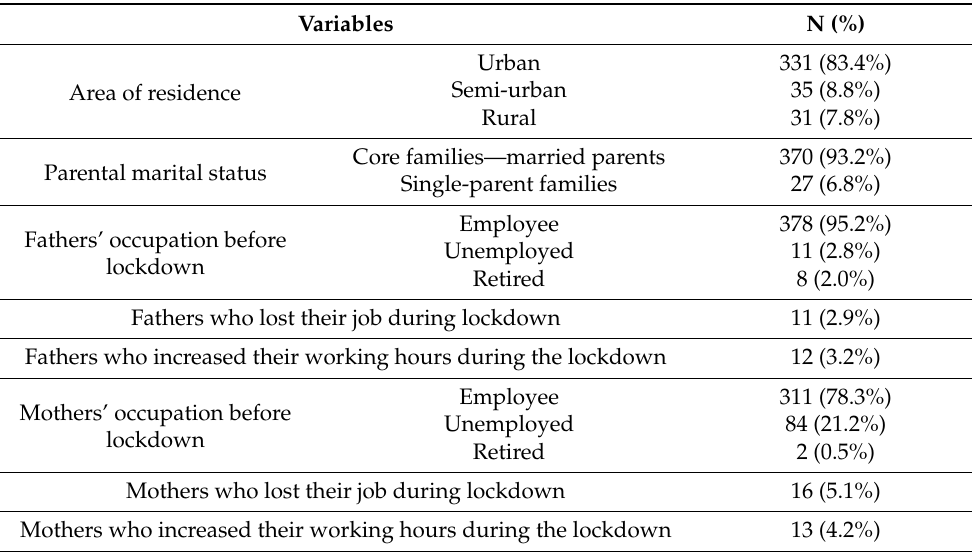
Table 2. Family socio-demographic status. The COV-EAT study.